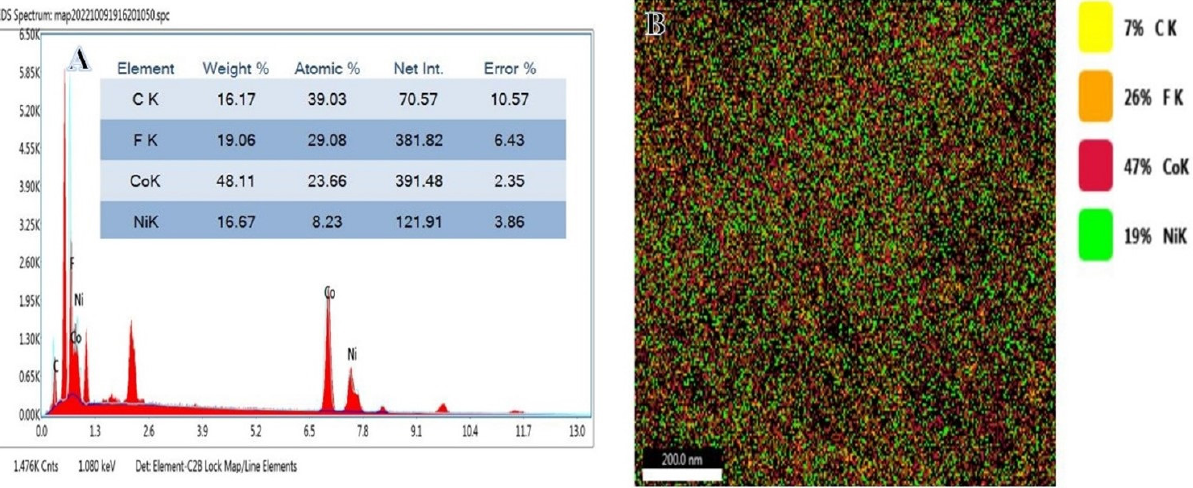
Figure 3. EDX chart of Ni 0.3 Co 0.7 @PVDF ‐ co ‐ HFP NFs membrane ( A ) and mapping showing the spread of elements ( B ), carbon ( C ), fluorine ( D ), cobalt ( E ), and nickel ( F ) in the Ni 0.3 Co 0.7 @PVDF ‐ co ‐ HFP NFs. XRD analysis of Ni 0.3 Co 0.7 @PVDF ‐ HFP and Ni 0.3 Co 0.7 @PVDF ‐ HFP membranes is shown in Figure 4A,B, respectively. It is obvious that two primary diffraction peaks exist at a 2 θ of 18.4° and 20.3°, which correspond to the (100) and (020)crystal indices,